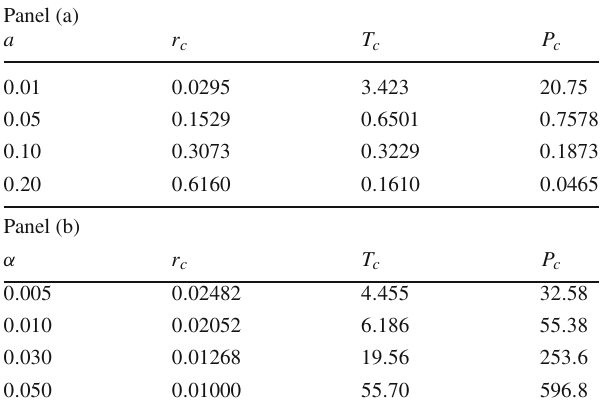
Table 1 Panel (a): critical values for α = 0 . 001 with different rotation parameter. Panel (b): critical values for a = 0 . 01 with different